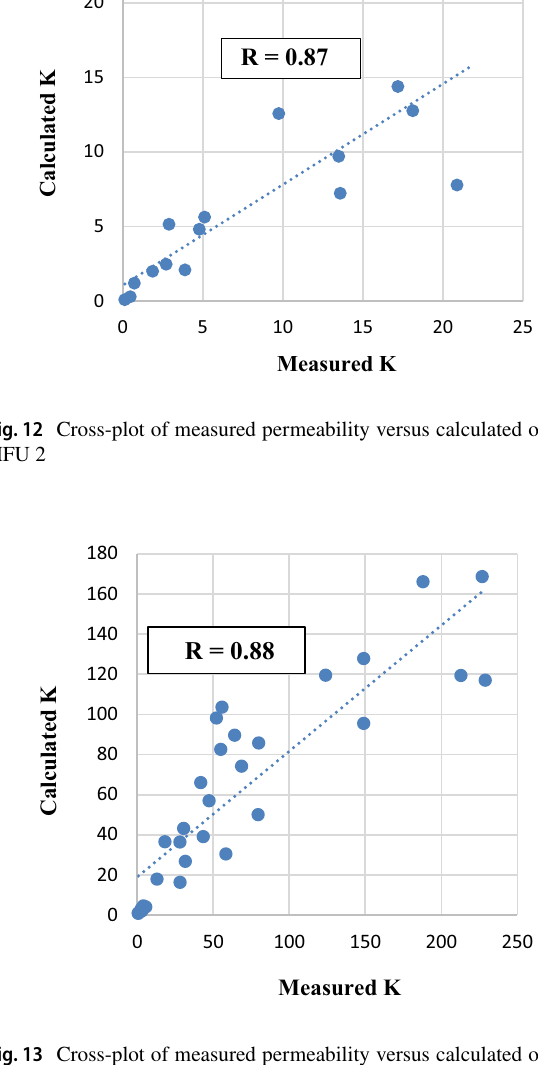
Fig. 13 Cross-plot of measured permeability versus calculated one of HFU 3